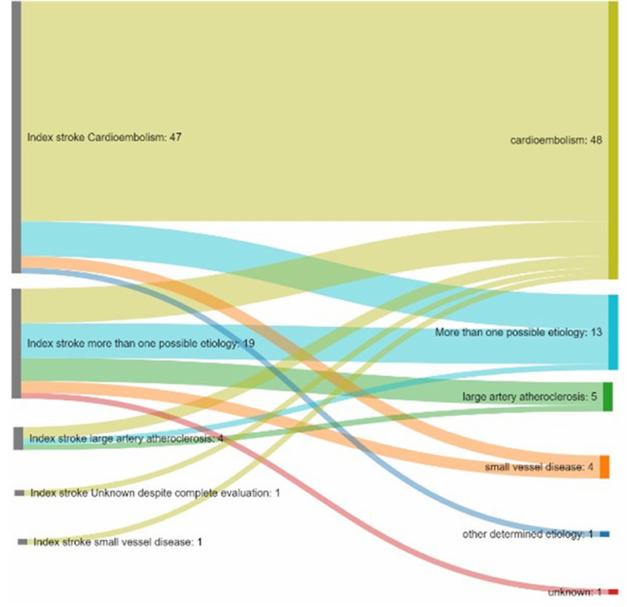
Figure 2. Detailed Illustration of patients with recurrent ischemic stroke. On the left side, the index stroke etiology is noted, on the right side the etiology of the recurrent stroke based on the TOAST classification. The flows represent the changes between the index and recurrent stroke